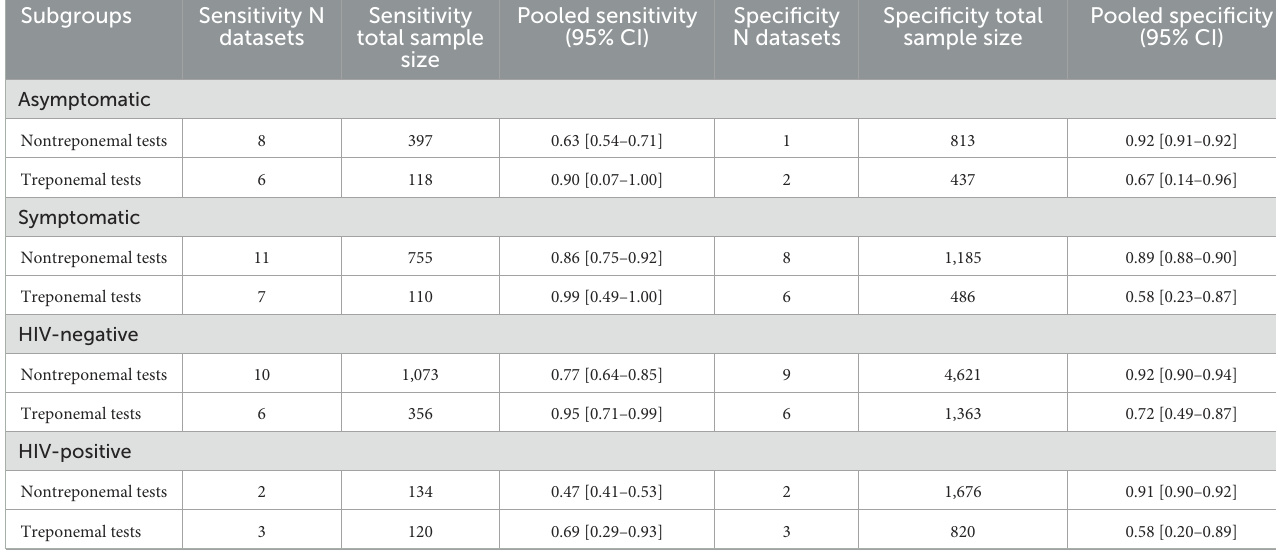
TABLE 2 Pooled sensitivity and specificity among subgroups of